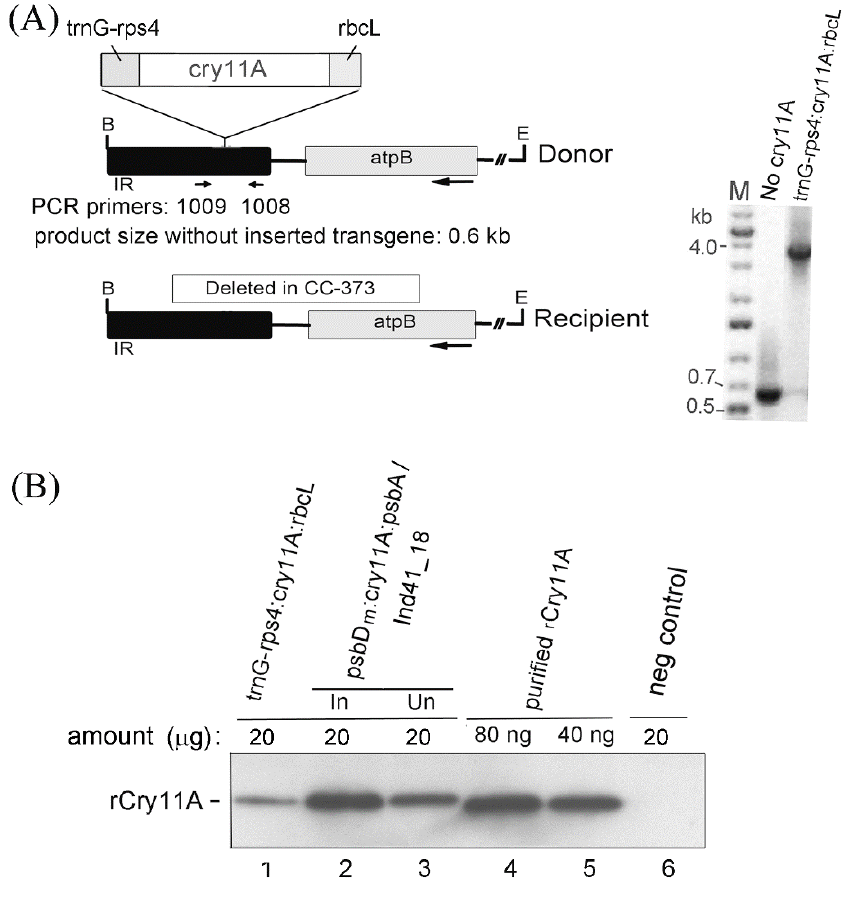
Figure 2. Transformation and expression of the trnG-rps4:cry11A:rbcL transgene in strain CC-373, which is complemented to wild-type by transformation. ( A ) (Left) Diagram of the transforming DNA (Donor) and the corresponding region of chloroplast DNA that is the homologous target in CC-373 (Recipient). The location of the PCR primers used to assess homoplasmicity is indicated. (Right) Gel of the PCR products from a trnG-rps4:cry11A:rbcL transformant and a transformant that did not integrate the transgene (No cry11A); lane M contained DNA size markers. ( B ) Western blot analysis of the trnG-rps4:cry11A:rbcL transformant from ( A ). Other lanes contained total protein from the inducible Ind41_18/ psbD m :cry11A:psbA strain grown under induced (In) and uninduced (Un) conditions (lanes 2 and 3, respectively), purified rCry11A produced in E. coli (lanes 4 and 5), and a transformant lacking the transgene (neg control, lane 6). For the total protein samples (lanes 1–3 and 6), 20 µ g of protein were loaded per lane as